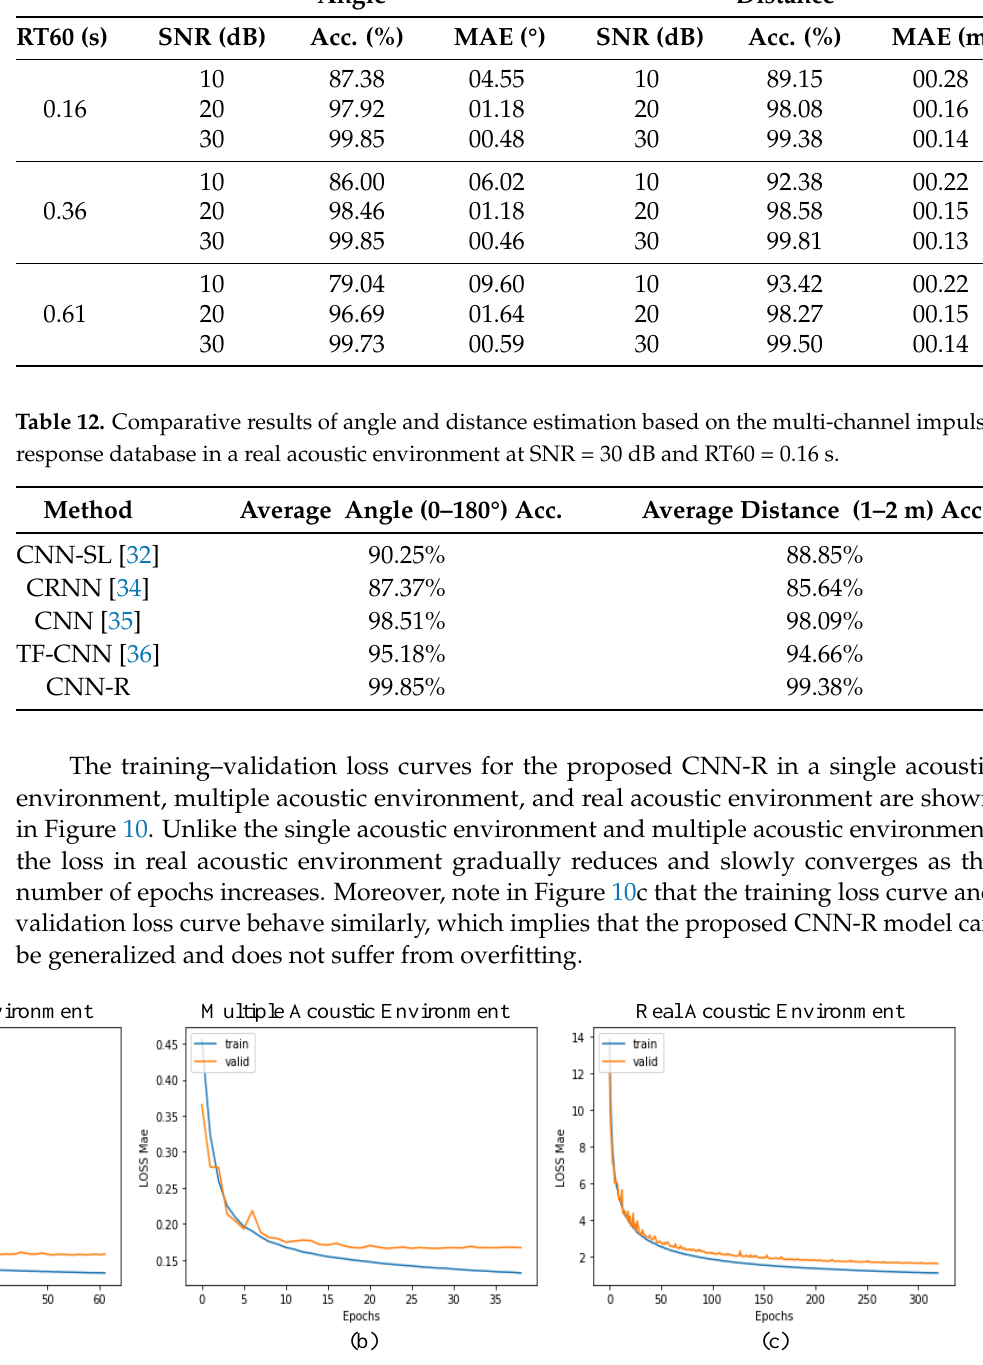
Figure 10. The training–validation loss curves of CNN-R, where ( a ) is the performance of CNN-R in a single acoustic environment. ( b ) is the performance of CNN-R in a multiple acoustic environment. ( c ) is the performance of CNN-R in a real acoustic